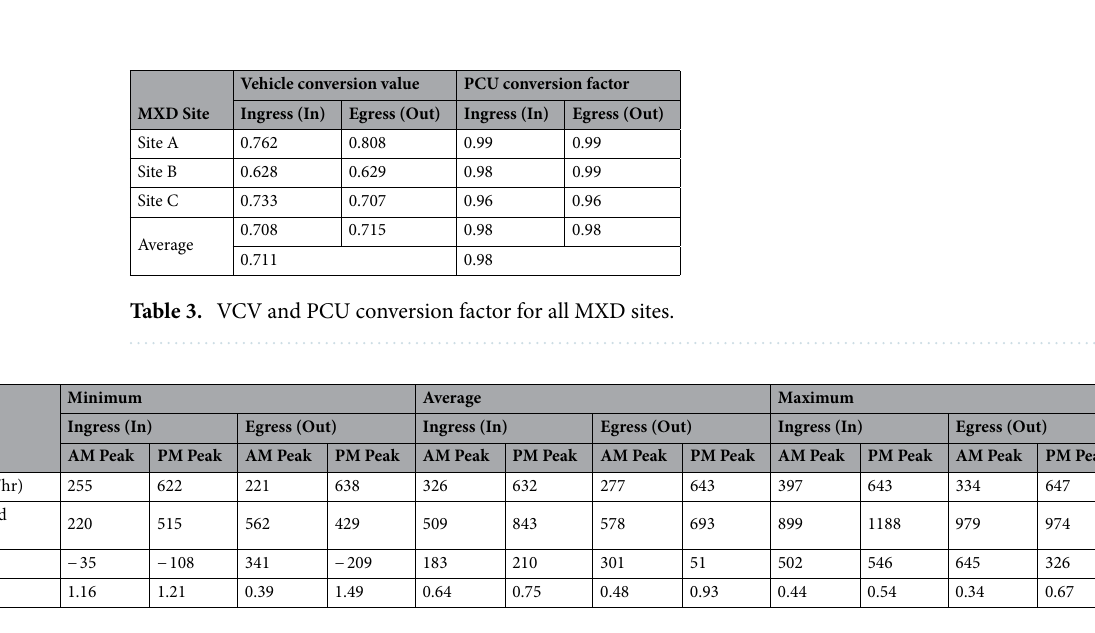
Table 4. Traffic volume, MTGM trip generated, and adjustment factor at 1st MXD site (Site A).